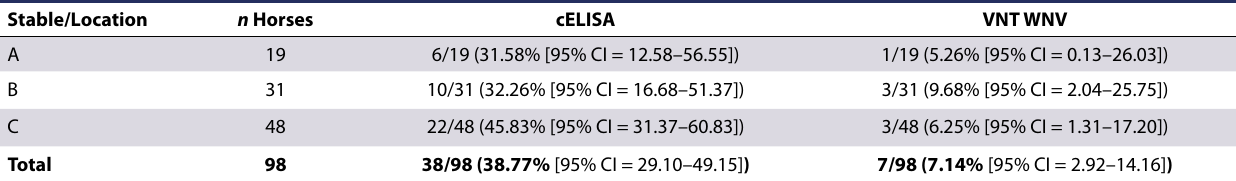
Table I: Seroprevalence of WNV in Windhoek horses Stable/Location n